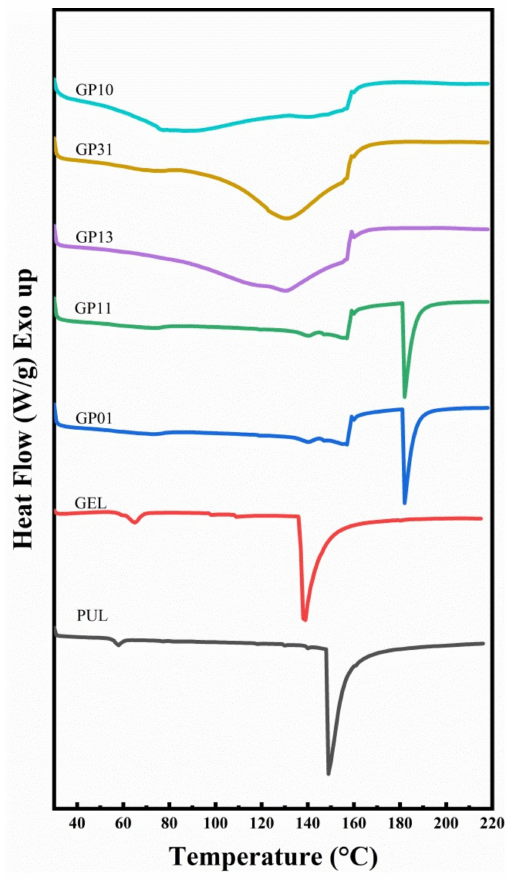
Figure 5. DSC heat flow diagrams for different